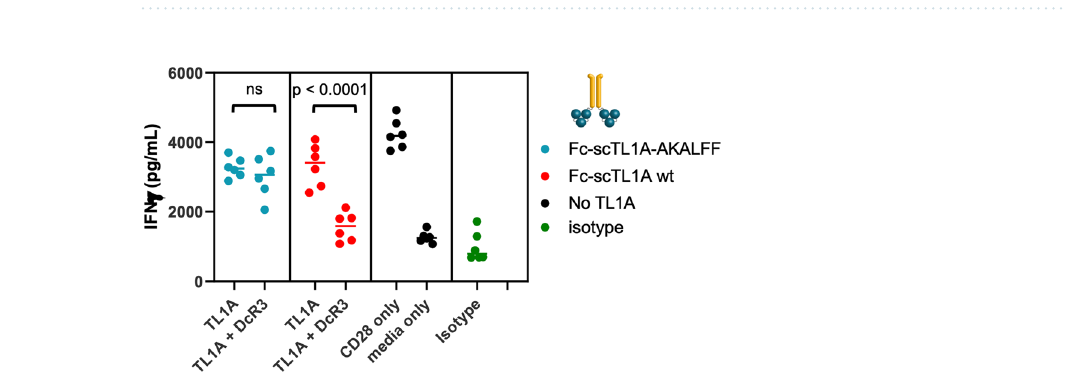
Table 3. ELISA results for TL1A variants.